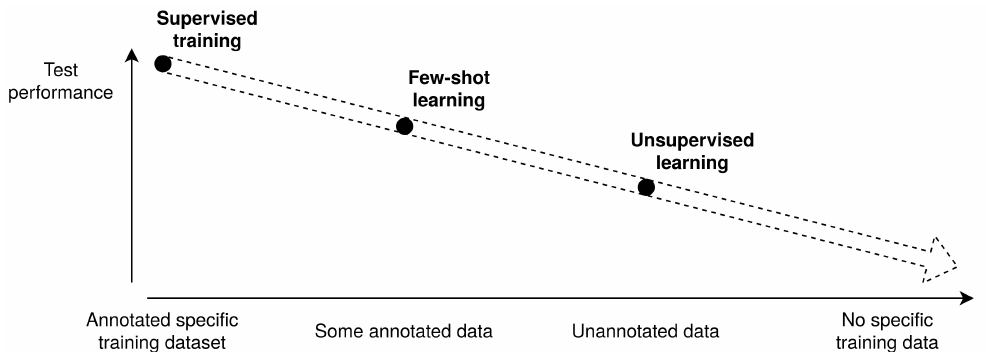
Figure 6. Overview of research topics along availability of training data. Typical learning setups differ according to their data-dependency ( x -axis), with expected test performance ( y -axis) decreasing with less training